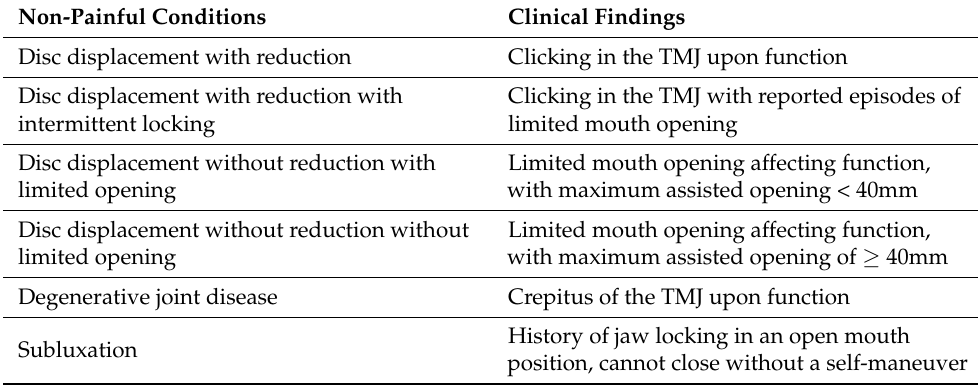
Clicking in the TMJ with reported episodes of limited mouth opening Limited mouth opening affecting function, with maximum assisted opening < 40mm Limited mouth opening affecting function, with maximum assisted opening of ≥ 40mm History of jaw locking in an open mouth position, cannot close without a self-maneuver